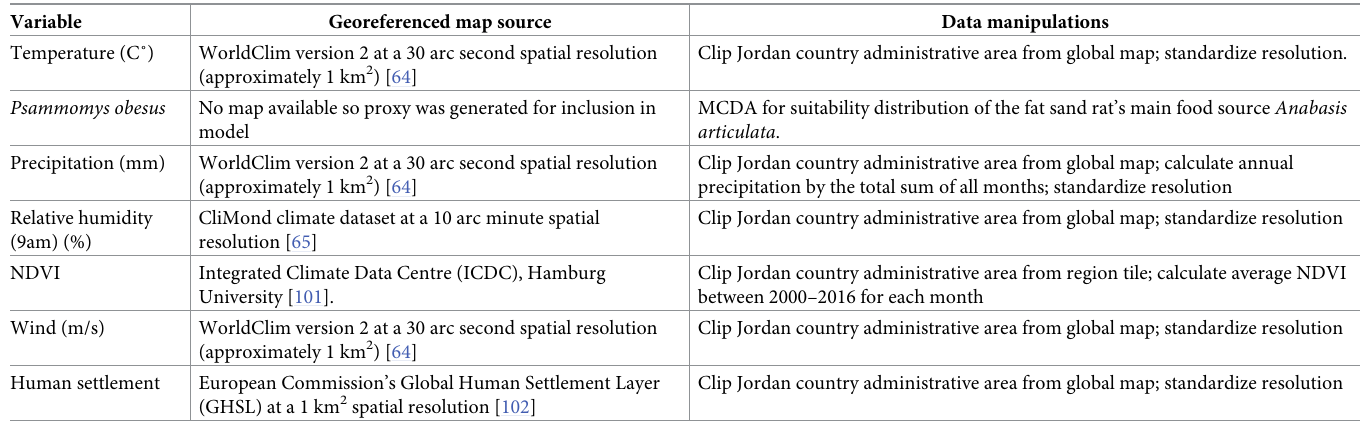
Table 2. Georeferenced data sources and manipulations for predictor variables.